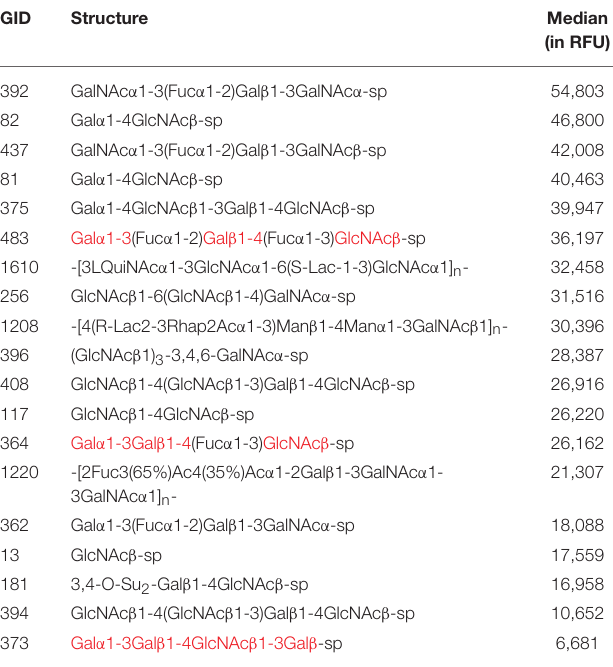
Listofglycanswithbindingsignalsabove10,000RFUatmonth6oflifeinalltheexamined mice (n = 5). GID 364, 372, and 483 contain the Galili epitope in their core structures (in red).